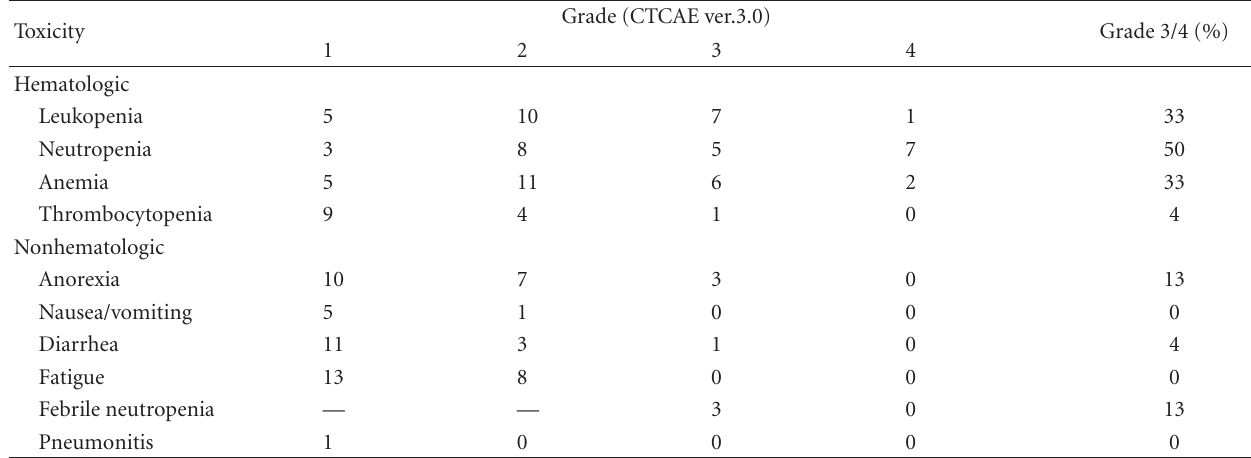
Table 3: Toxicity (24